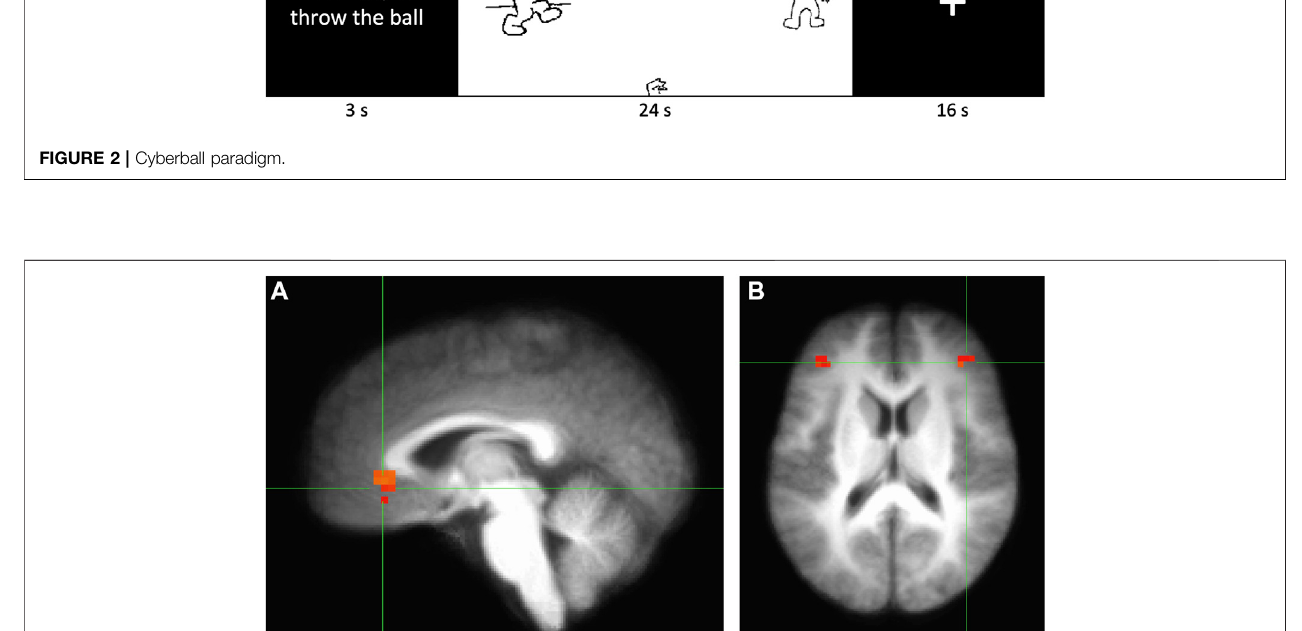
FIGURE3 | Increased activation of thevmPFC (A) and the dlPFC in conditions ofinterest.vmPFCcluster size (cid:1) 21 MNIcoordinates (cid:1) 2, − 32, − 3dlPFC leftcluster size (cid:1) 13 MNI coordinates (cid:1) 36, − 37, 19. dlPFC right cluster size (cid:1) 9 MNI coordinates (cid:1) − 39, − 30, 29 Uncorrected p (cid:1) 0.01, corrected p (cid:1) 0.05.